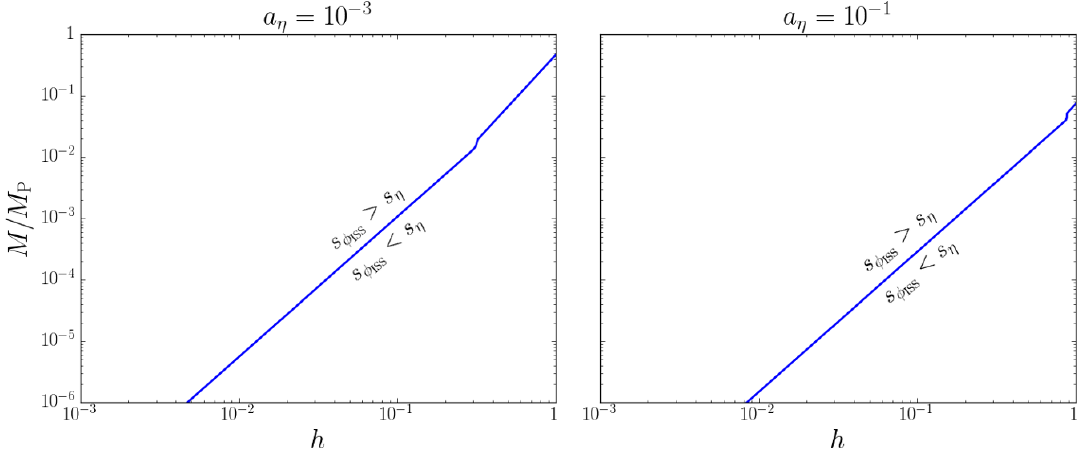
Figure 2 . The curves of s (cid:30) = s (cid:17) numerically obtained from equations (4.33) and (4.35) at the ISS decay epoch of S 2 , the last decaying particle, for small (large) coupling a (cid:17) = 10 (cid:0) 3 ( a (cid:17) = 10 (cid:0) 1 ). Above the curves, the energy density (cid:26) r becomes larger, implying also larger total entropy density (cid:30) ISS at the decay time of S 2